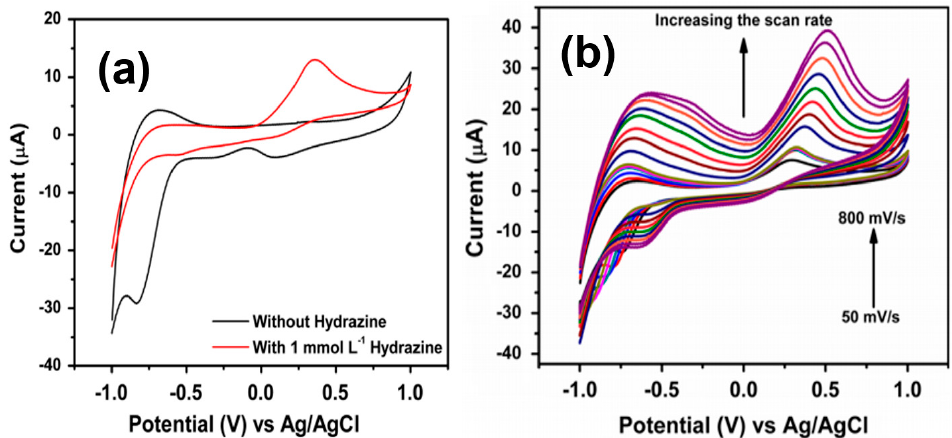
Figure 2. ( a ) Typical cyclic voltammetry (CV) sweep curve for Ag-ZnO nanoellipsoids/Au modified electrode with and without 11.0 mmol·L − 1 hydrazine in 0.1 mol·L − 1 phosphate buffer solution (PBS; pH ~7) at scan rate of 100 mV/s; ( b ) CV sweep curves at different scan rates (50, 60, 70, 80, 90, 100, 200, 300, 400, 500, 600, 700, and 800 mV/s) of Ag-ZnO nanoellipsoids/Au modified electrode. Adapted